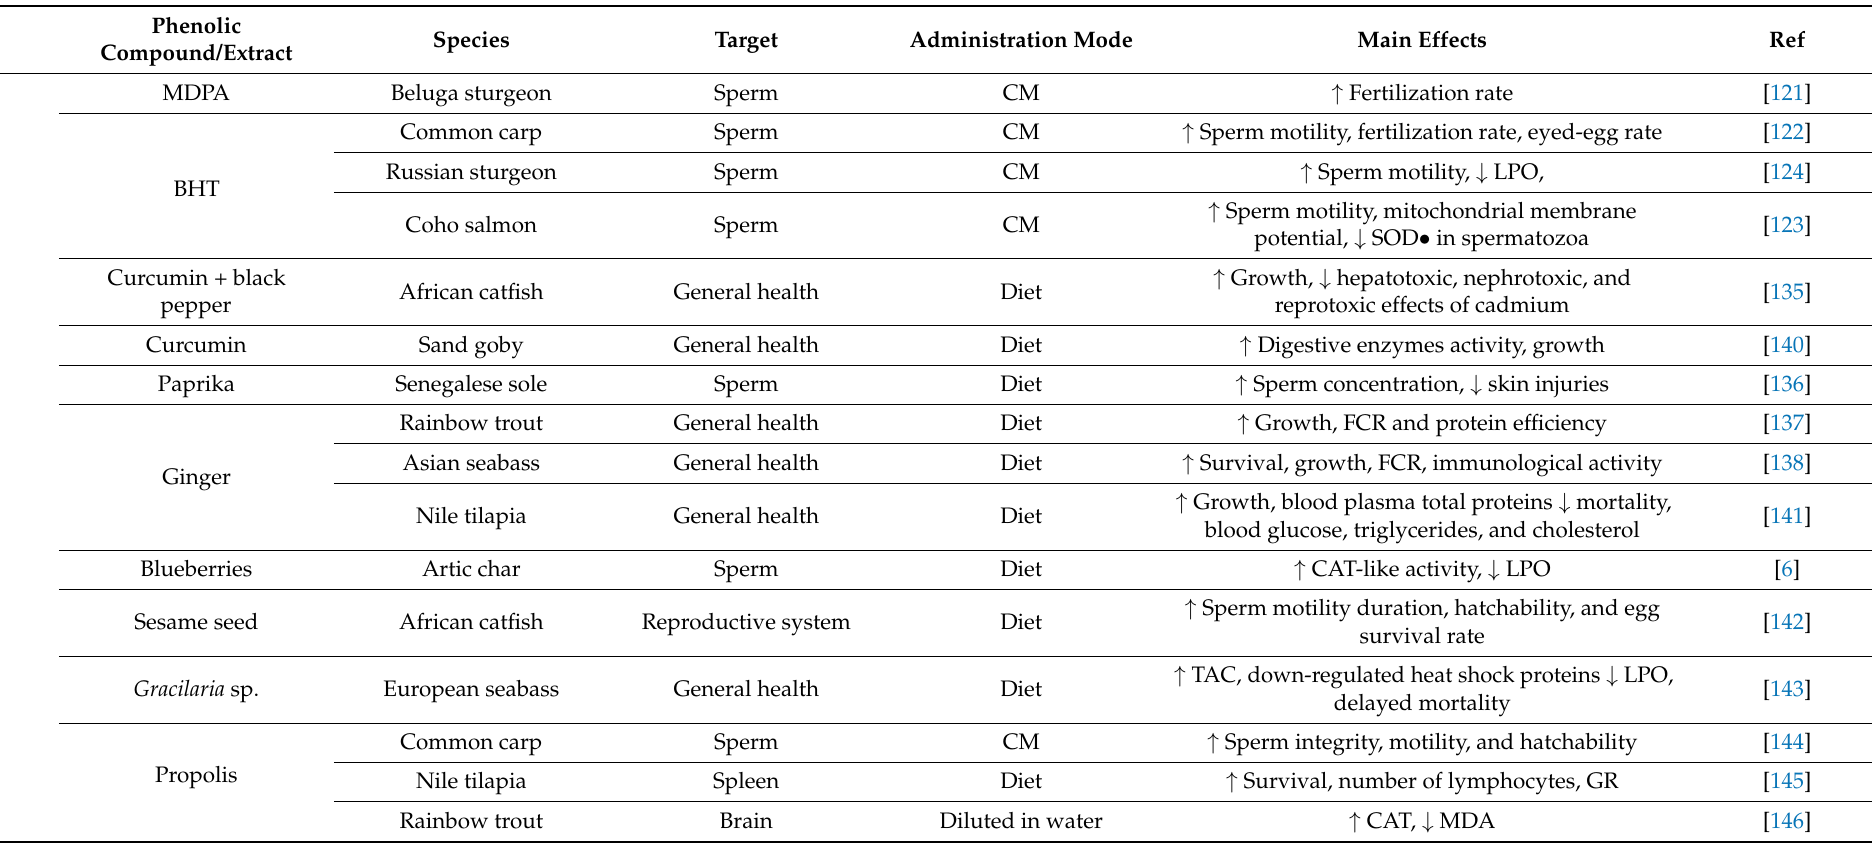
Table 1. Polyphenolic compounds used as antioxidants on target tissues of fish and mammals. CM—cryoprotectant medium, LPO—lipid peroxidation, SOD • —superoxide dismutase anion, FCR—feed conversion ratio, TAC—total antioxidant capacity, GR—glutathione reductase, CAT—catalase, MDA—malondialdehyde acid, ROS—reactive oxygen species, SOD—superoxide dismutase,